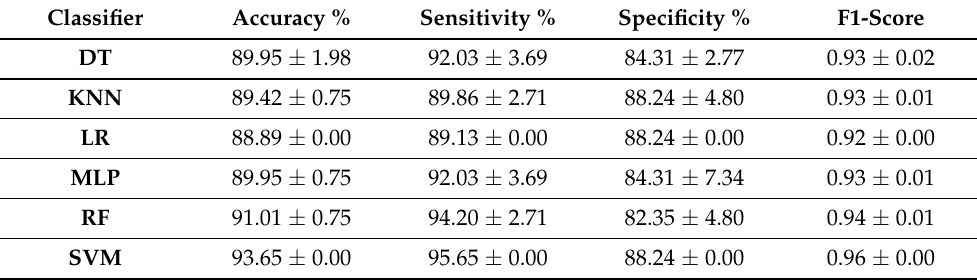
Table 4. The evaluation metrics (reported in mean ± standard deviation after 10 repetitions) of different ML classifiers using stratified 10-fold cross-validation approach, along with the integrated group of extracted features.